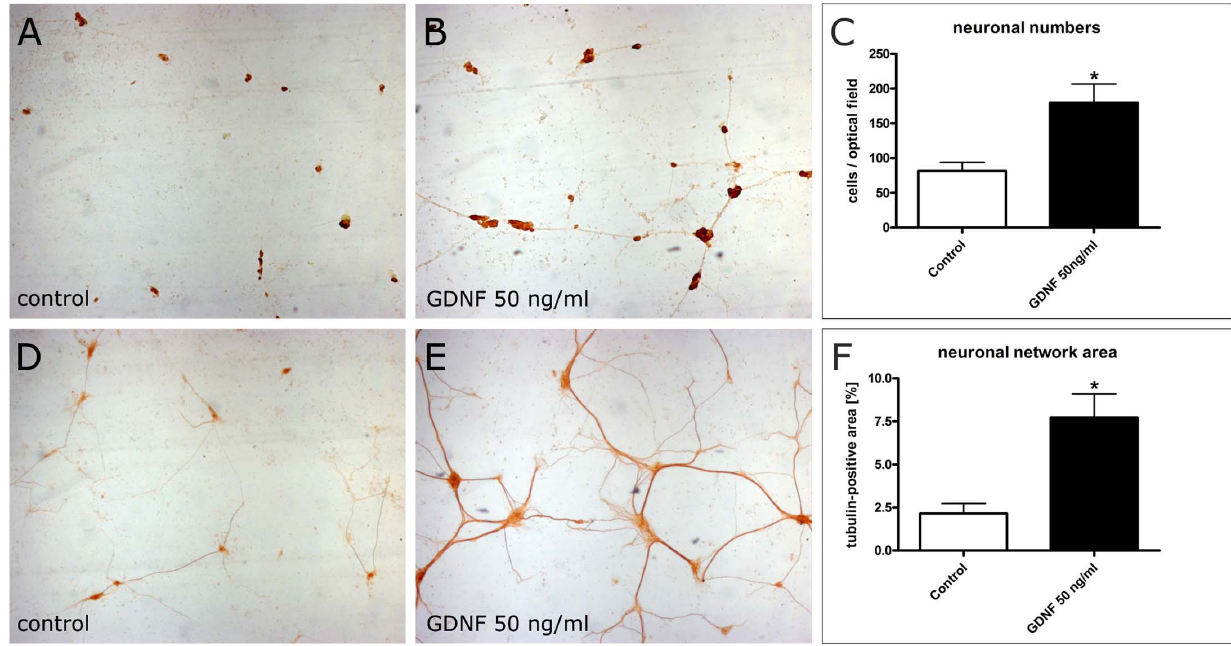
Figure 4. Effects of GDNF on neuronal number and differentiation of enteric nerve cell cultures. Rat enteric nerve cells were cultured for 1 week without (A, D) or with 50 ng/ml GDNF (B, E). Immunocytochemistry for the neuronal marker HuC/D (A, B) shows that neuronal aggregates are more numerous and larger after GDNF treatment. The morphometric analysis (C) confirms the increased neuronal number following GDNF treatment. Immunocytochemistry for tubulin ßIII (D, E) visualizes neuronal processes which are more densly distributed and ramified after GDNF treatment. The morphometric analysis (F) confirms the increased area of the neuronal network following GDNF treatment. Magnification 4 6 . Data are shown as mean + / 2 SEM, n (HuC/D immunocytochemistry)=11–12, n (ßIII tubulin immunocytochemistry)=7–8 per experimental group, *p , 0.05 vs.